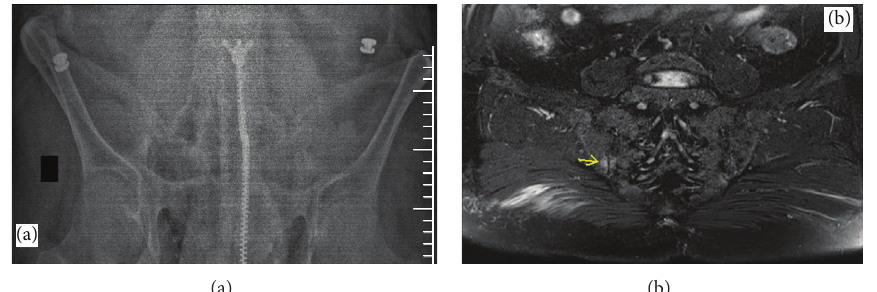
Figure 1: (a) Plain sacroiliac joint X-ray showing irregularities in each joint space (apparent in the right). (b) Evident bone marrow edema area in right side on sacroiliac magnetic resonance (MR) (yellow